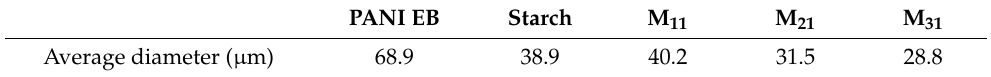
Table 2. Average particle diameters of PANI, STARCH, and PANI/starch biocomposites.